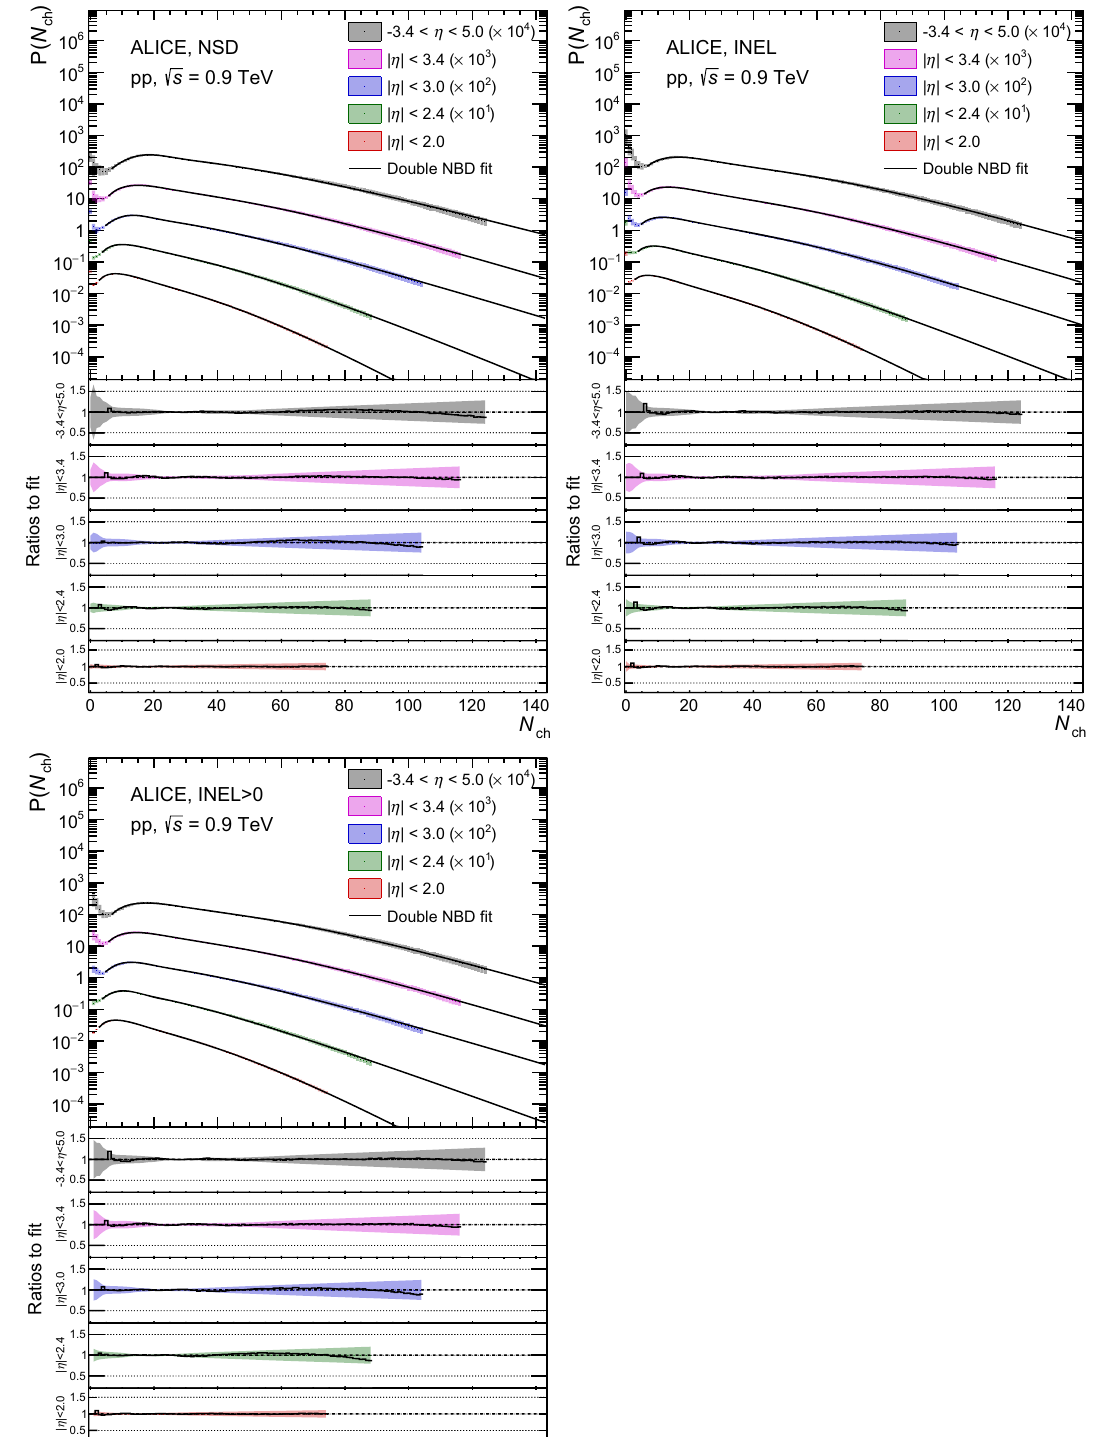
presented. Combined systematic and statistical uncertainties are shown √ s = 0 . 9 TeV. as